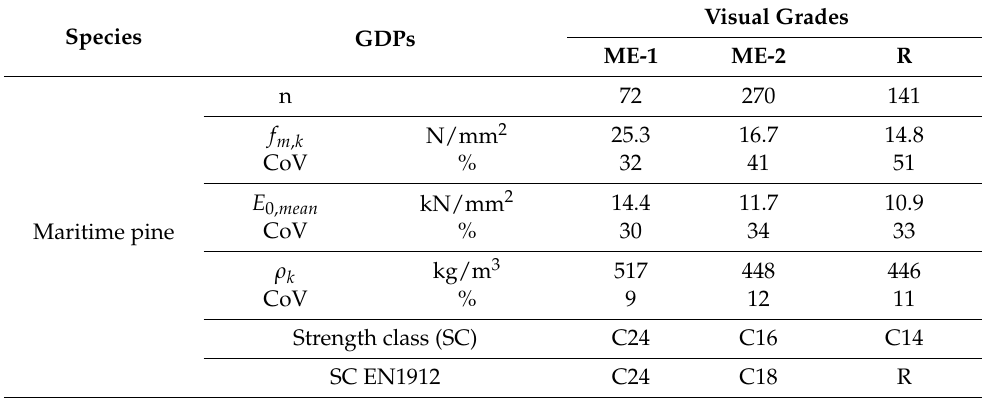
Table 5. Characteristic values of the mechanical and physical properties for each visual